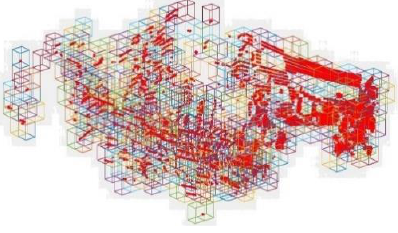
Figure 2. Point cloud voxelization.